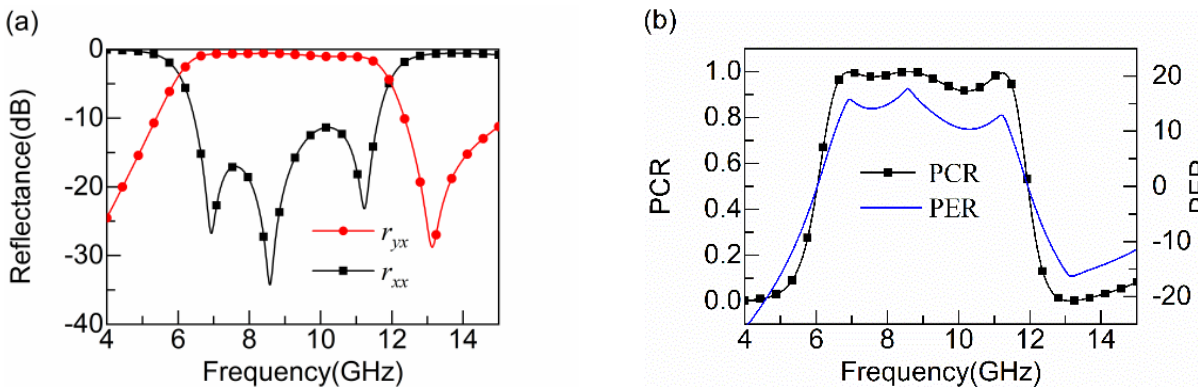
Figure 2. Simulated results ( a ) reflectance; ( b ) PCR and PER.